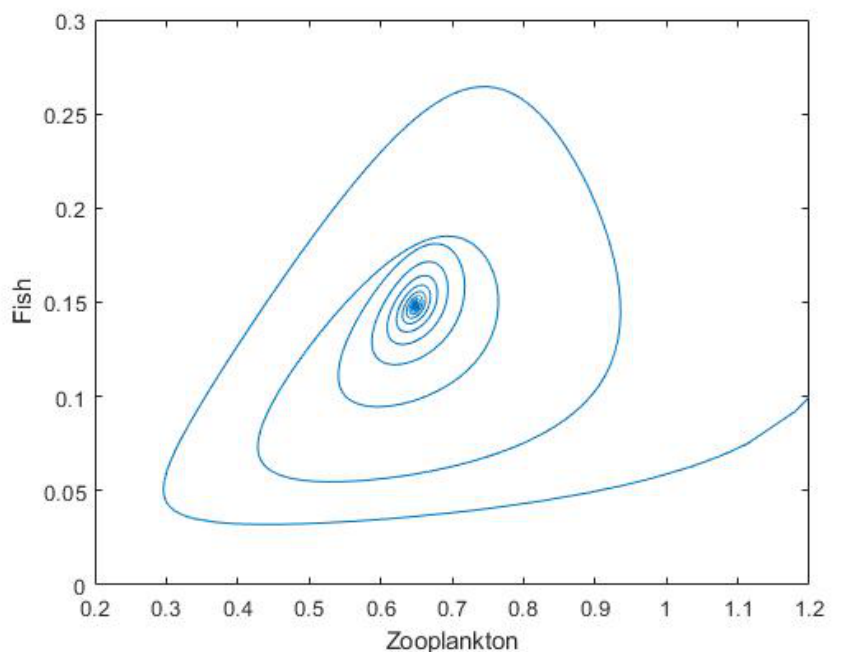
Figure 23. The asymptotical stability between the zooplankton and fish populations for τ = τ −